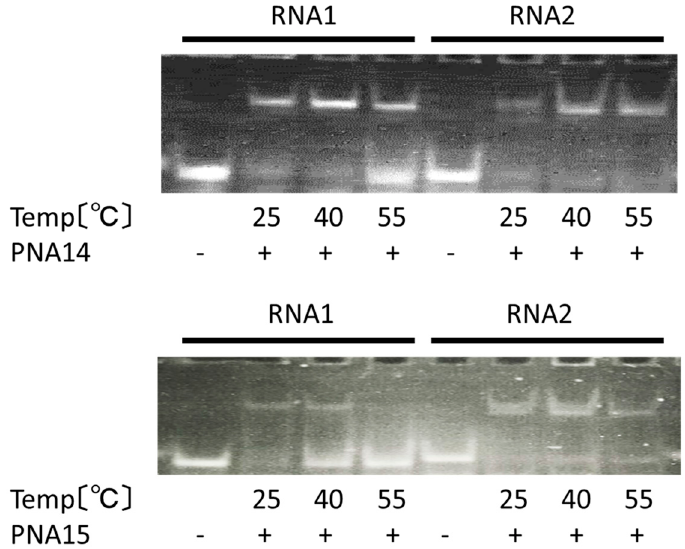
Figure 9. Gel mobility shift assay to assess single nucleotide polymorphism recognition in an RNA oligonucleotide (RNA 1 , RNA 2 ) by PNA 13 and PNA 14 . RNA 1 contains the partial sequence from neuraminidase inhibitor-sensitive influenza A/Yokohama/1/H1N1, while RNA 2 contains the partial sequence from the neuraminidase inhibitor-sensitive influenza A/Yokohama/77/H1N1. PNA; 300 nM, RNA; 100 nM, incubation; 10 mM phosphate buffer (pH 6.0); and, 1 mM EDTA at room temperature for 10 min., gel shift assay; 15% acrylamide gel, 20 mA, 60 min.